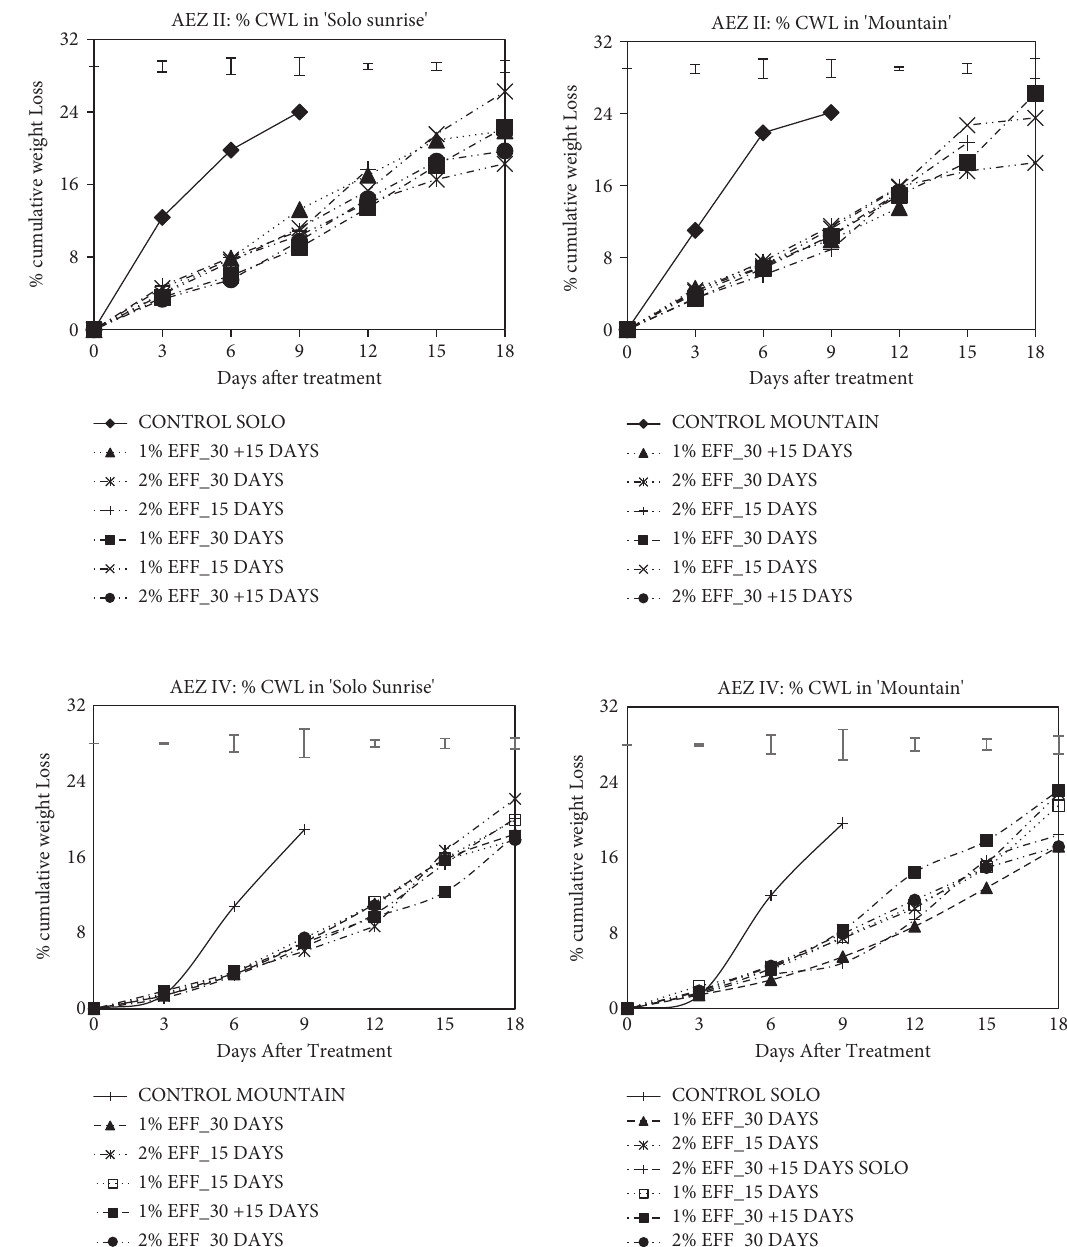
Figure 4: Papaya % cumulative weight lost for Hexanal sprayed fruits from Machakos and Meru counties. Top bars represent LSD at